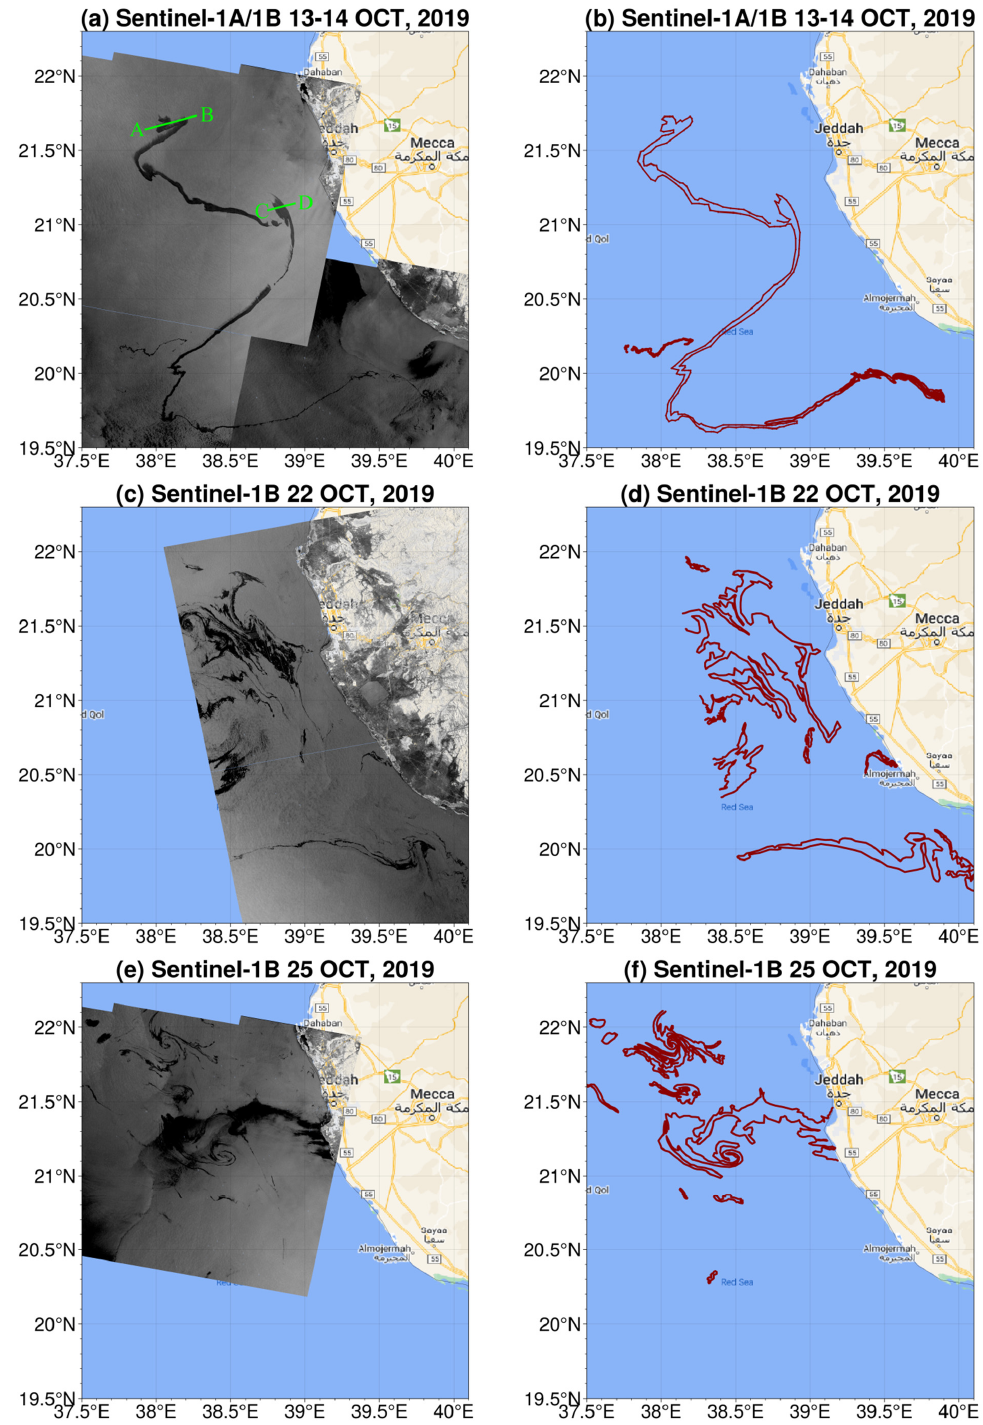
Figure 3. Mosaic of Sentinel-1A and Sentinel-1B imageries collected on ( a ) 13 and 14 October 2019 (two days after the spill), ( c ) 22 October 2019 (12 days after the spill), ( e ) 25 October 2019 (15 days after the spill). Panels ( b , d , f ) are the same as ( a , c , e ), except that they use a dark red line to indicate the outline of the oil